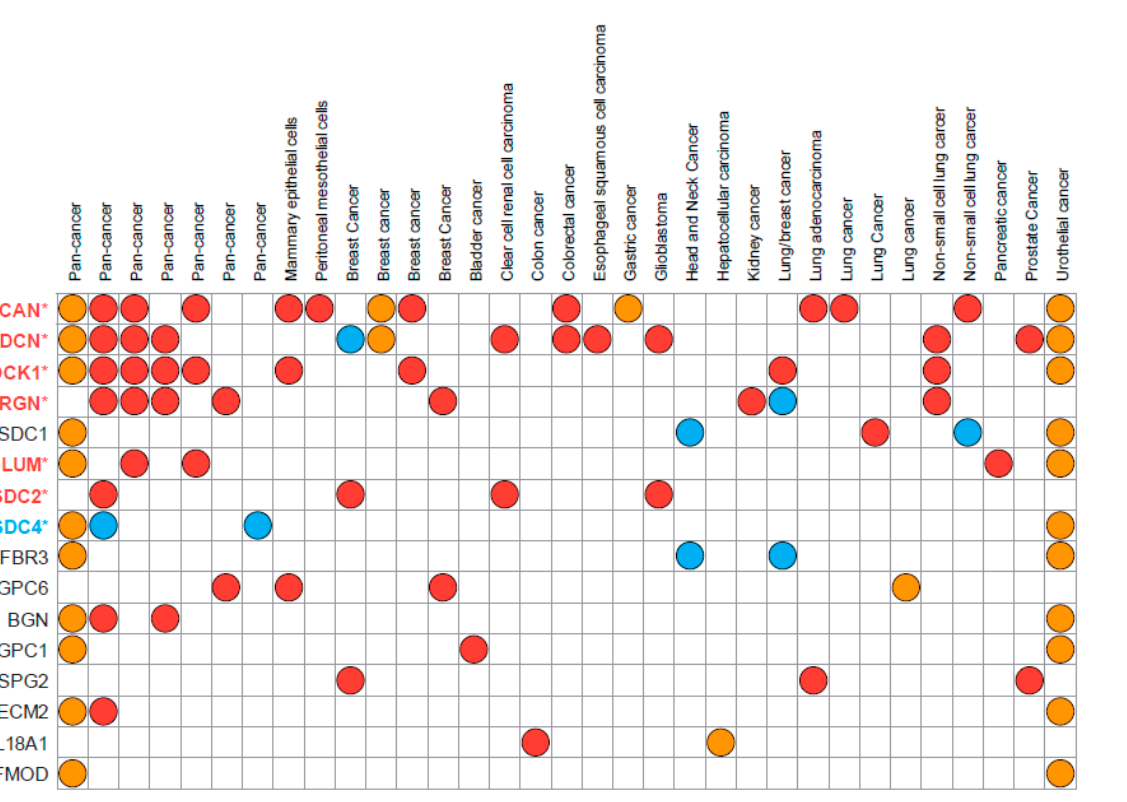
Figure 2. Proteoglycans found in the proposed EMT signatures deposited in the EMTome database. Eighty-four EMT signatures were downloaded from the EMTome database (http://www.emtome.org/ (accessed on 19 August 2022)) and searched for overlap with 42 proteoglycans. Only proteoglycans identified in at least two signatures are displayed in the figure. Red color indicates association towards the mesenchymal phenotype, blue towards the epithelial phenotype, and yellow indicates that no association towards either the mesenchymal or epithelial phenotype was found in the proposed dataset. Proteoglycans with stars after their name were also discovered as TGF β -responsive genes in our own publication (PMID: 35494005) Here, colors of the name represent their association to either epithelial (blue) or mesenchymal (red) phenotypes.